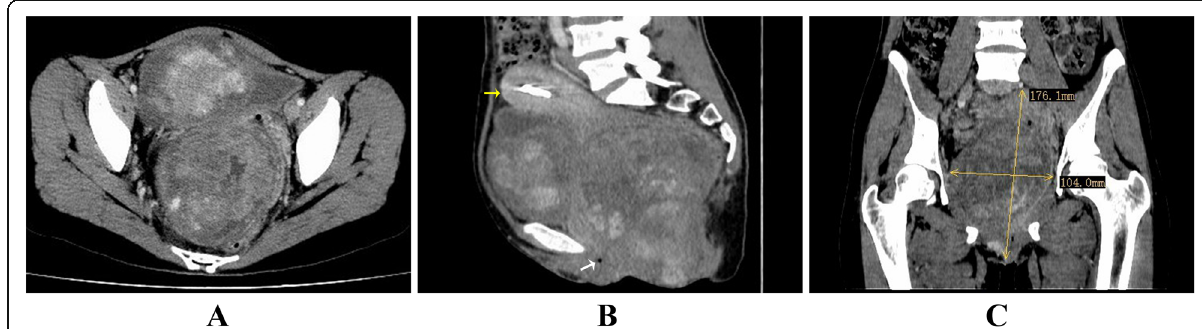
Fig. 1 The computed tomography images of the patient with vaginal dedifferentiated liposarcoma. Abdominal computed tomography (CT) showed a 17.6 cm× 10.4 cm solid mass in pelvic cavity. Transverse ( a ), sagittal ( b ) and coronal ( c ) CT images revealed the tumor mass was highly suspected to originate from vagina. The yellow arrow indicate uterus, and the white arrow indicate the part of vaginal